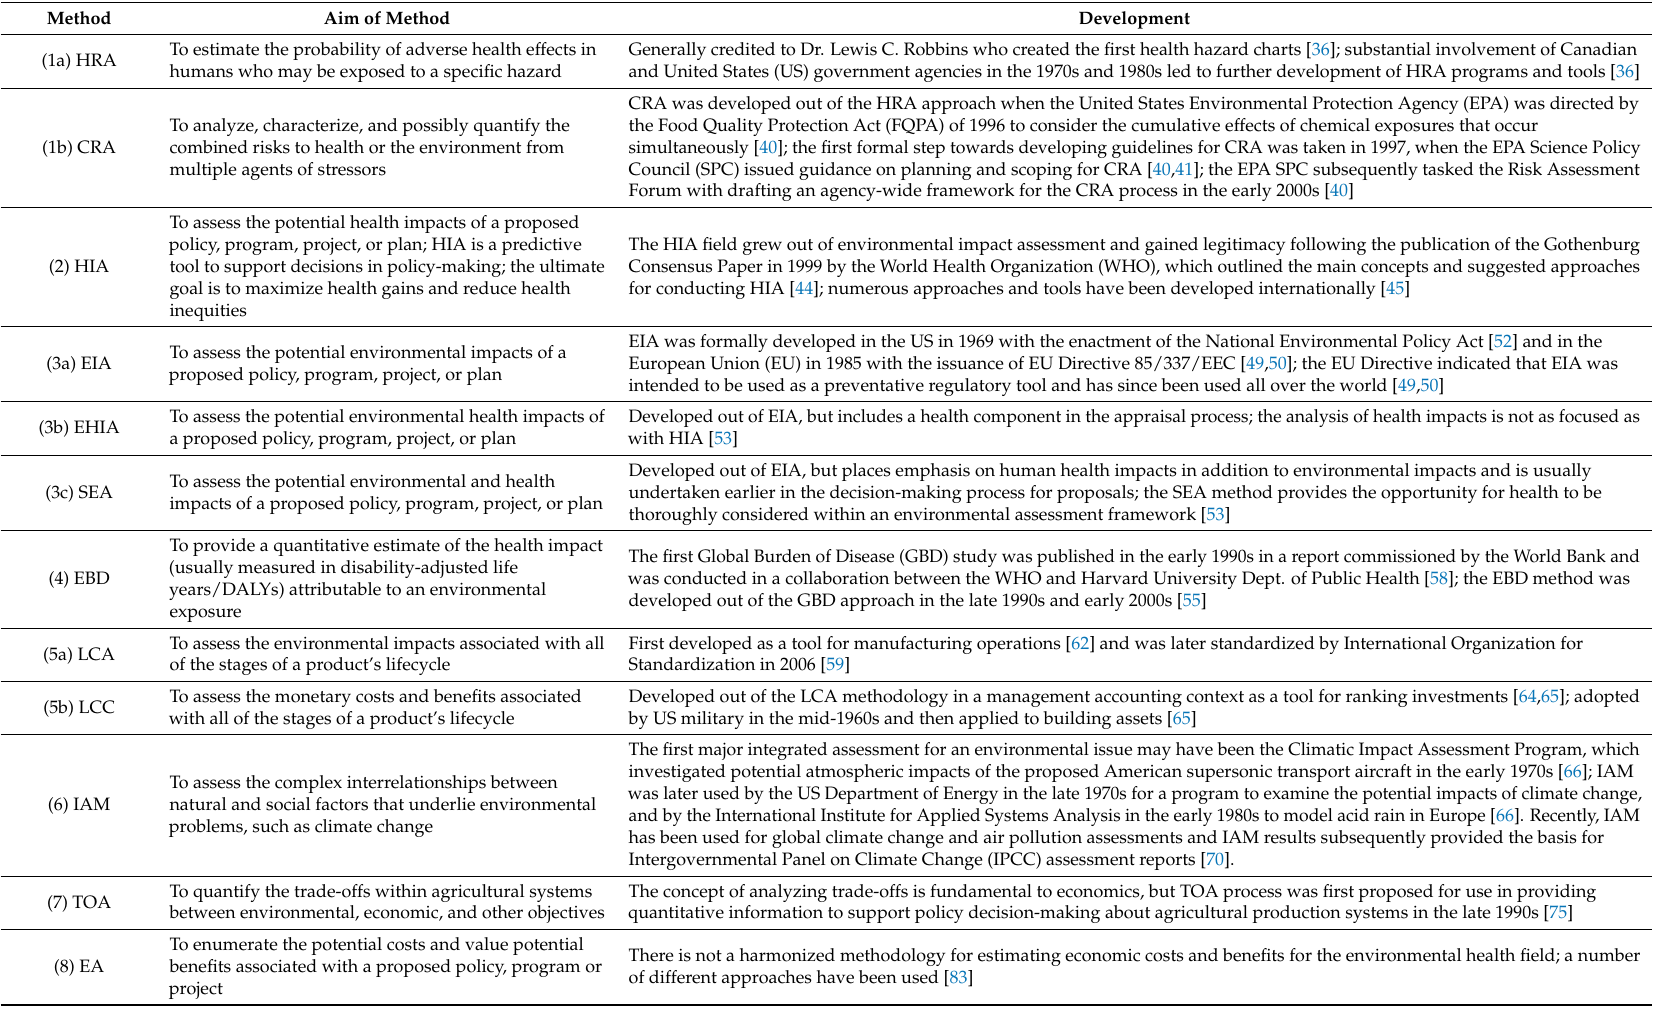
Table 2. The characteristics of methods applicable to assessing the environmental health impacts of an agricultural